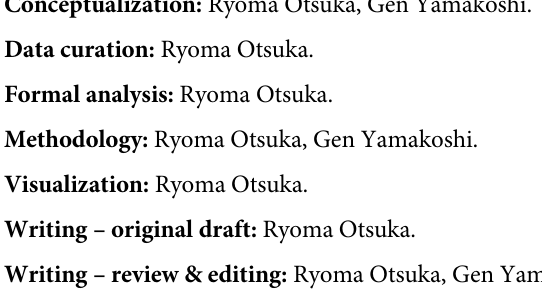
S1 Table. The explanatory variables we used in models exploring factors that affect the number of views and likes of YouTube videos related to mountain gorilla tourism. S2 Table. Summary of the full model exploring factors that affect the number of views of YouTube videos related to mountain gorilla tourism. (N = 206). S3 Table. Summary of the full model exploring factors that affect the number of likes of YouTube videos related to mountain gorilla tourism. (N =